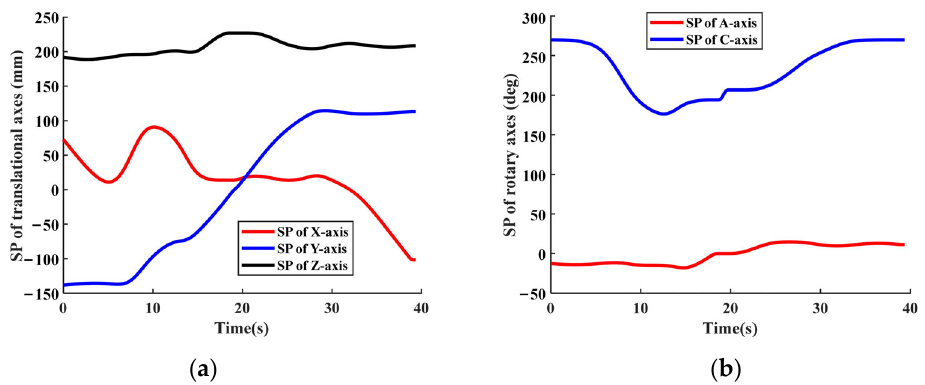
Figure 16. SP of each axis of the KMC400S U five ‐ axis machine tool. ( a ) SP of translational axes; ( b ) SP of rotary axes.